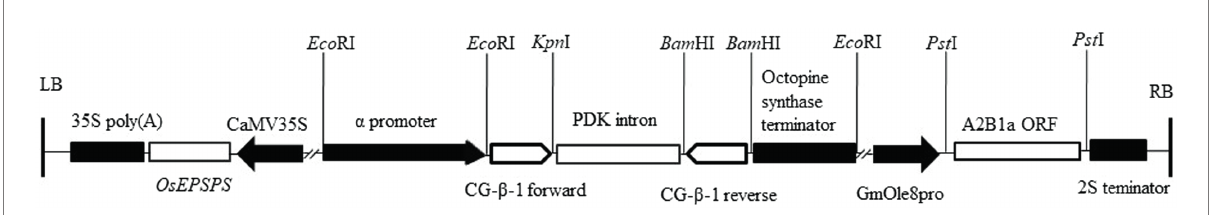
FIGURE 1 Schematic diagram of pCambia1300-OsEPSPS-RNAi-GmOle8pro-A2B1a. The soybean transformation construct contains the A2B1a subunit coding region (A2B1a ORF) under the control of the soybean oleosin8 promoter (GmOle8pro) and the 3 ′ -end noncoding region of 2S albumin (2S terminator). The RNAi cassette under the control of the soybean α -promoter of β -conglycinin and the octopine synthase terminator, together with 302 bp fragments obtained from sequences of CG- β -1 gene forward and reverse inserted side of PDK intron, respectively. The OsEPSPS gene under the control of the cauliflower mosaic virus 35S promoter (CaMV35S) and 35S poly(A) terminator acted as a selective marker. Eco RI, Kpn I, Bam HI and Pst I restriction sites are shown on the vector. LB, left border; RB, right